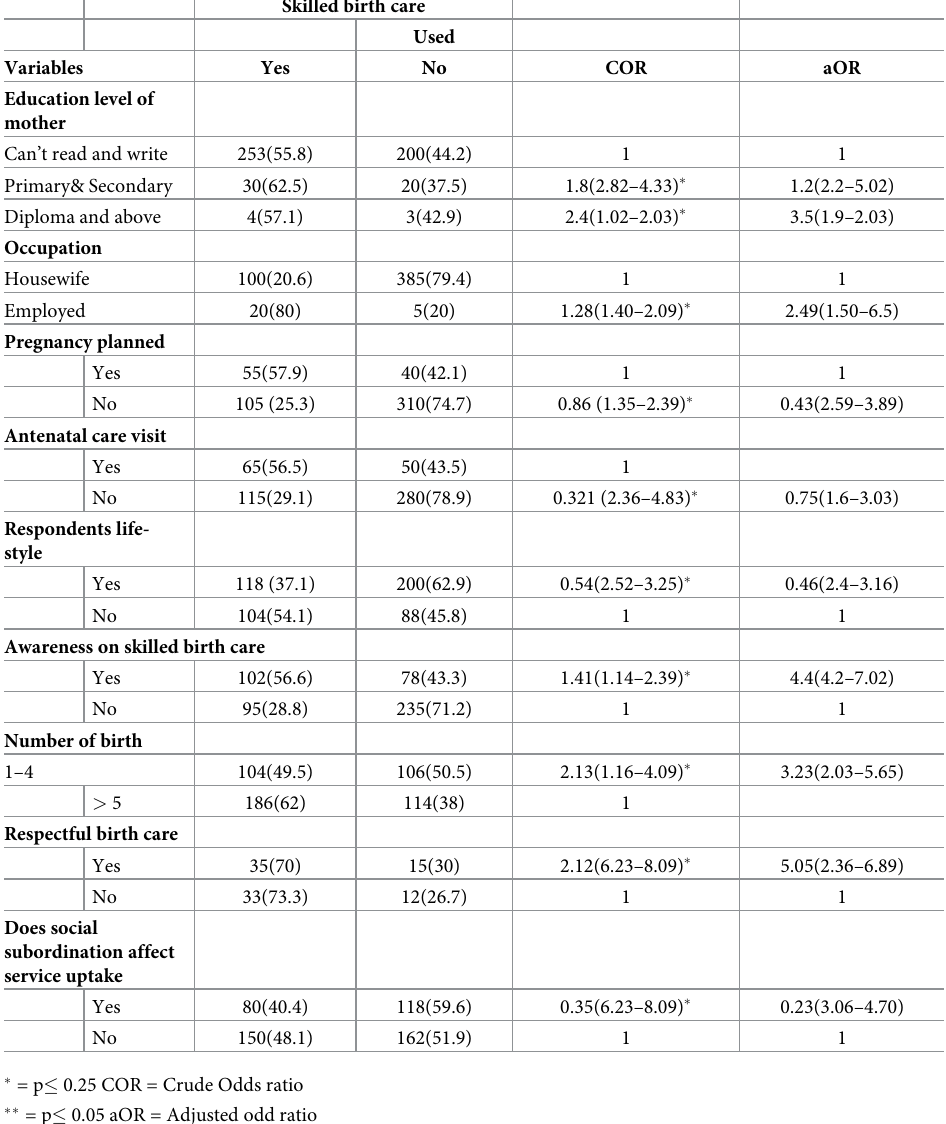
Table 3. Factors associated with skilled birth care uptake among women in socially disadvantaged minorities, Kambata-Tambaro zone, Southern Ethiopia,